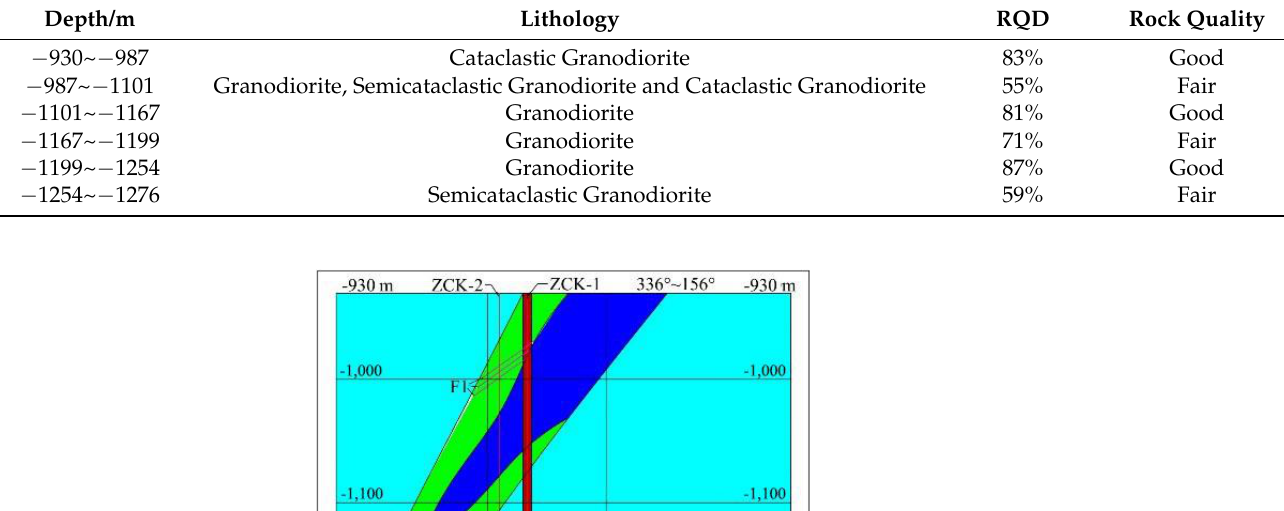
Table 1. Correlation between RQD and rock quality at different depths.